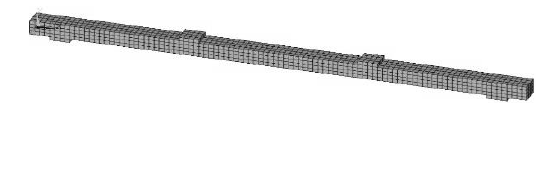
Figure 2. The meshing of larch wood